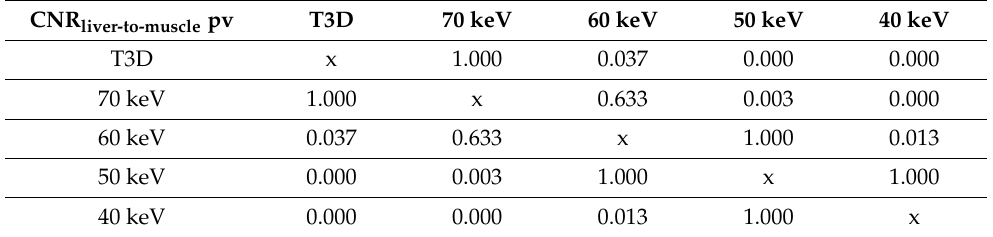
Table 10. Comparison of portal venous CNR liver-to-muscle between T3D and low keV images. CNR liver-to-muscle pv T3D 70 keV